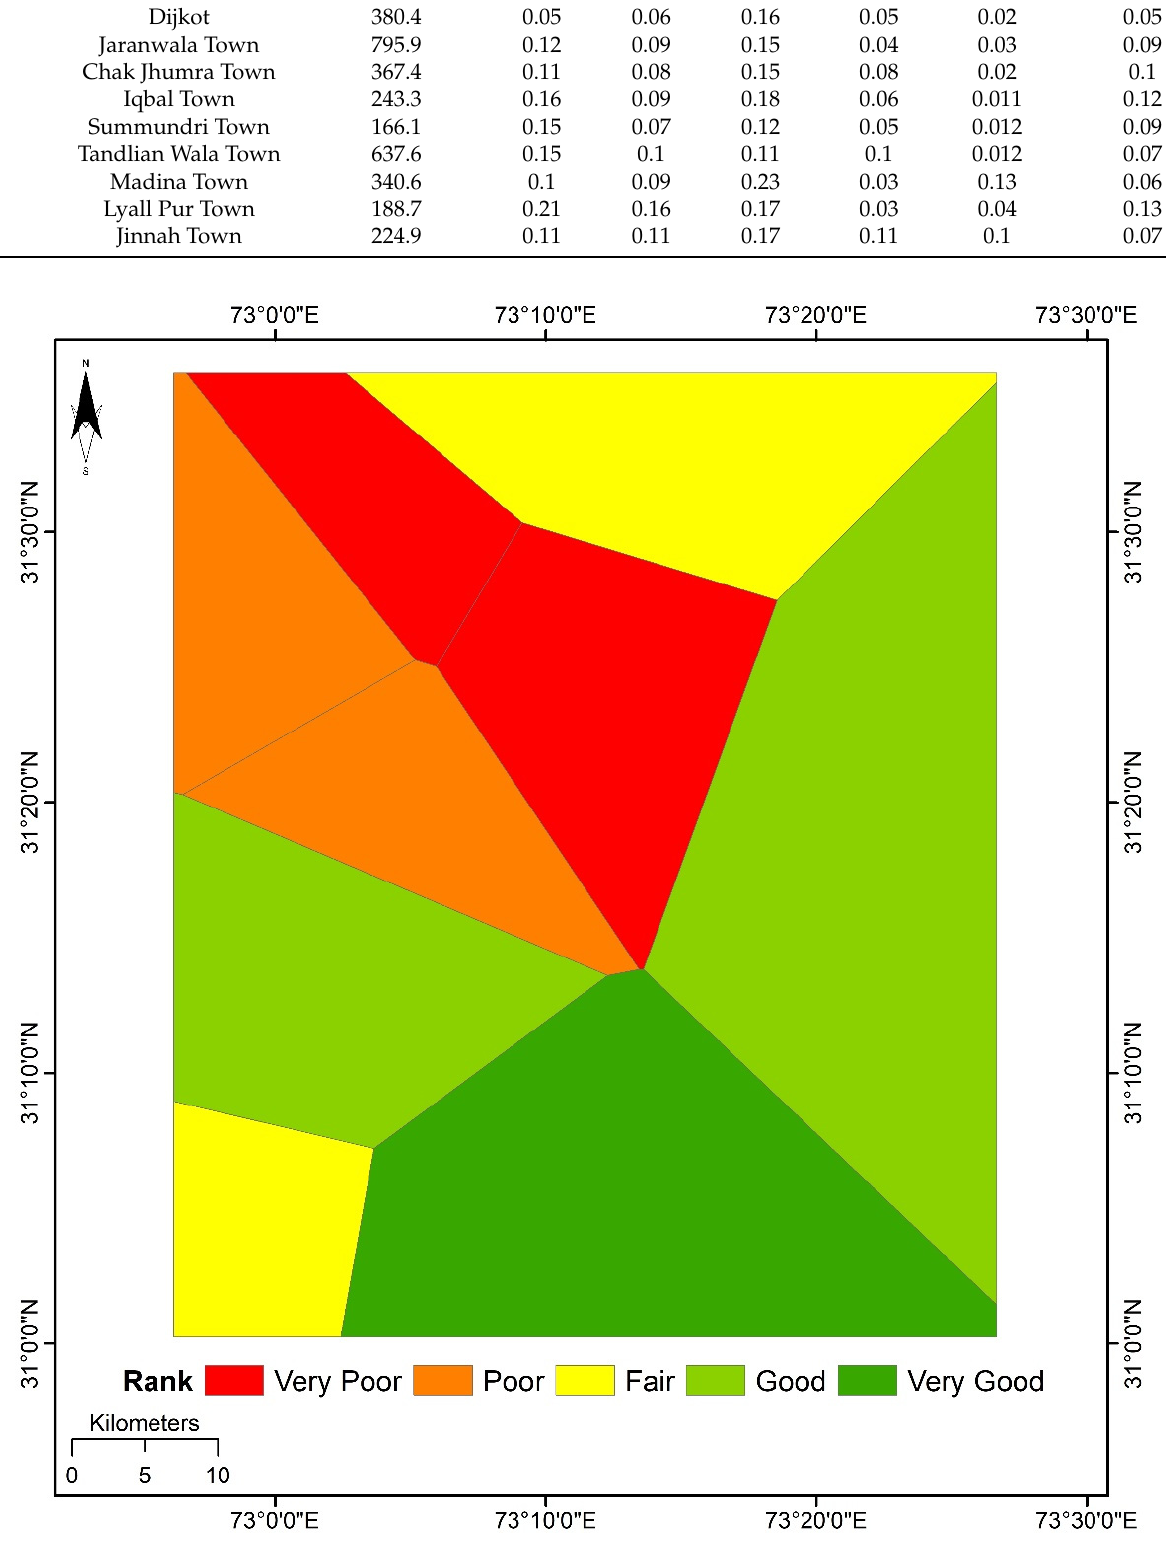
Figure 10. Ranked Thiessen polygons from Zonal Statistics.